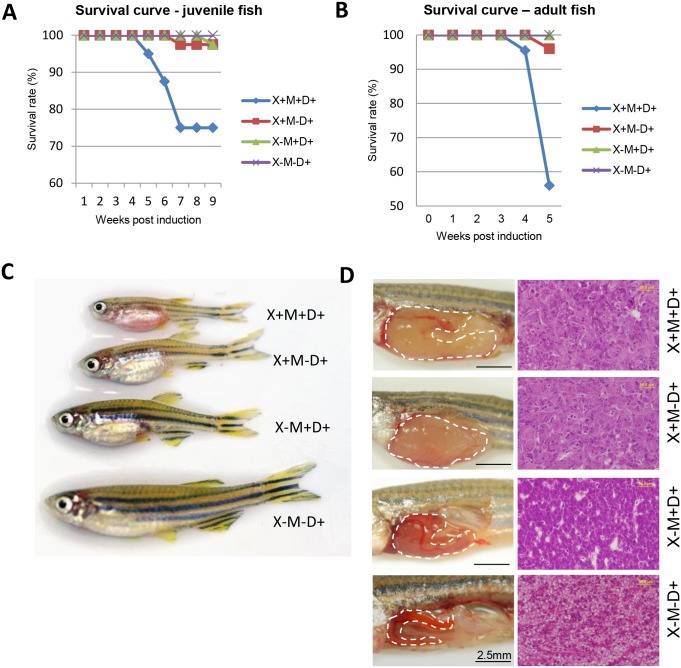
Synergistic effect of Myc and xmrk oncogenes in transgenic zebrafish survival and liver tumorigenesis.(A,B) Survival curve (A) and gross morphology (B) of oncogene transgenic zebrafish following doxycycline induction at the juvenile stage (starting from 21 dpf). (C) Survival curve of oncogene transgenic zebrafish following doxycycline induction at the adult stage (starting from 3.5 mpf). (D) Gross observation of liver phenotype (left) and histological sections of livers stained by hematoxylin and eosin dyes (right). Abbreviations: X,xmrk; M,Myc; D, doxycycline treatment.